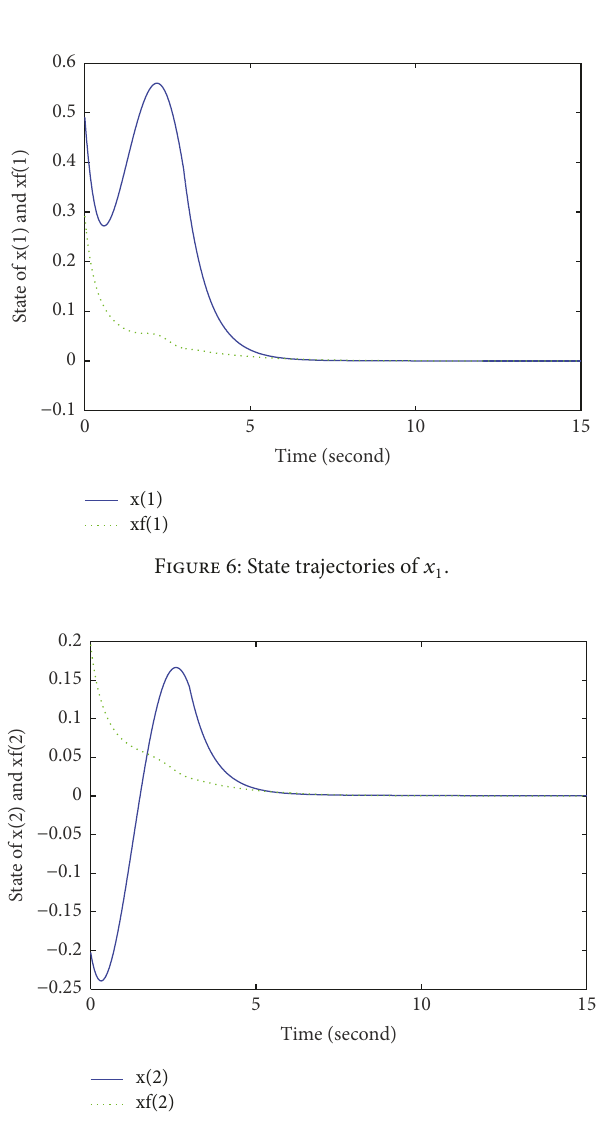
Figure 7: State trajectories of 𝑥 2